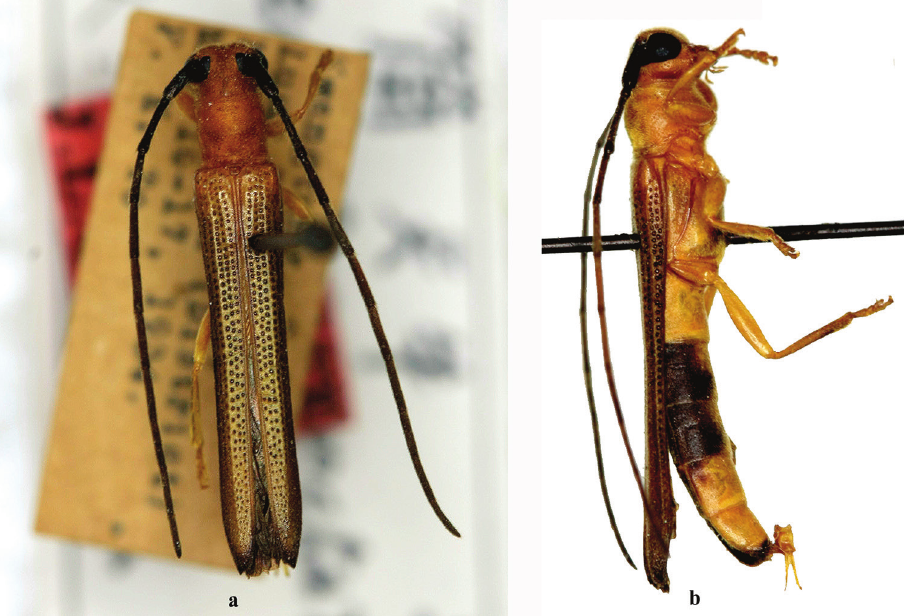
Figure 3. Habitus of O. toi Gressitt, 1939, holotype, female, from Guangdong, a dorsal view b lateral view. (not to